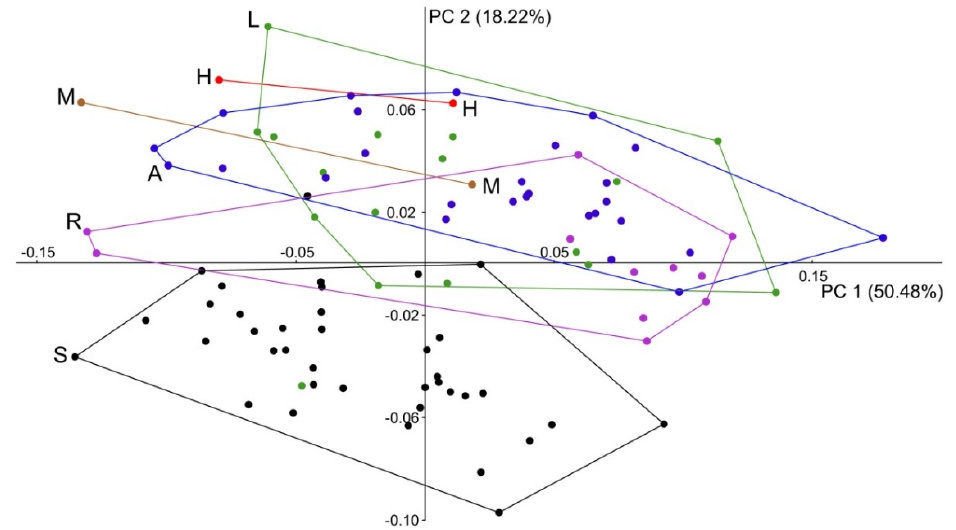
Figure 2. The PCA plot for M. hartingi (the 1st axis versus the 2nd axis). Abbreviations: A, blow dots, M. h. ankaraensis ; H, red dots, M. h. hartingi ; L, green dots, M. h. lydius ; M, brown dots, M. h. martinoi ; R, violet dots, M. hartingi from the Eastern Rhodope Mountains; and S, black dots, M. h. strandzensis. Along the top and right margins of the plot, measurement abbreviations are displayed with values of the relation between a parameter and the axes.